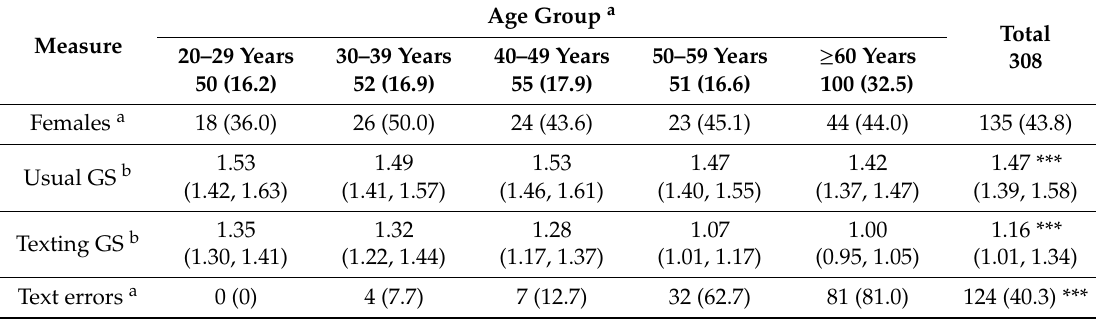
Table 1. Characteristics of the study population by age group.